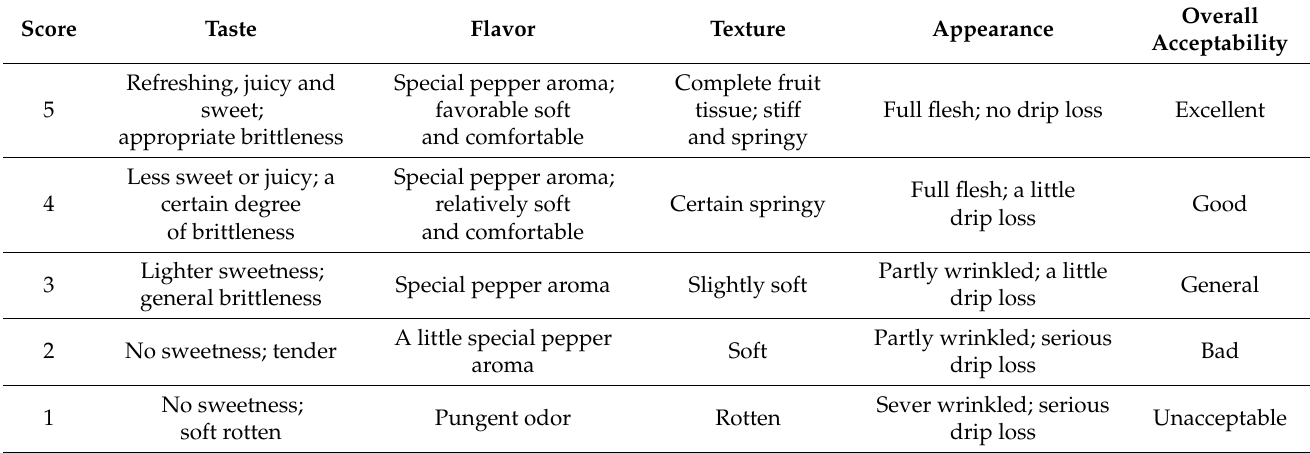
Table 2. The standard score sheet for the sensory evaluation of the fresh-cut bell